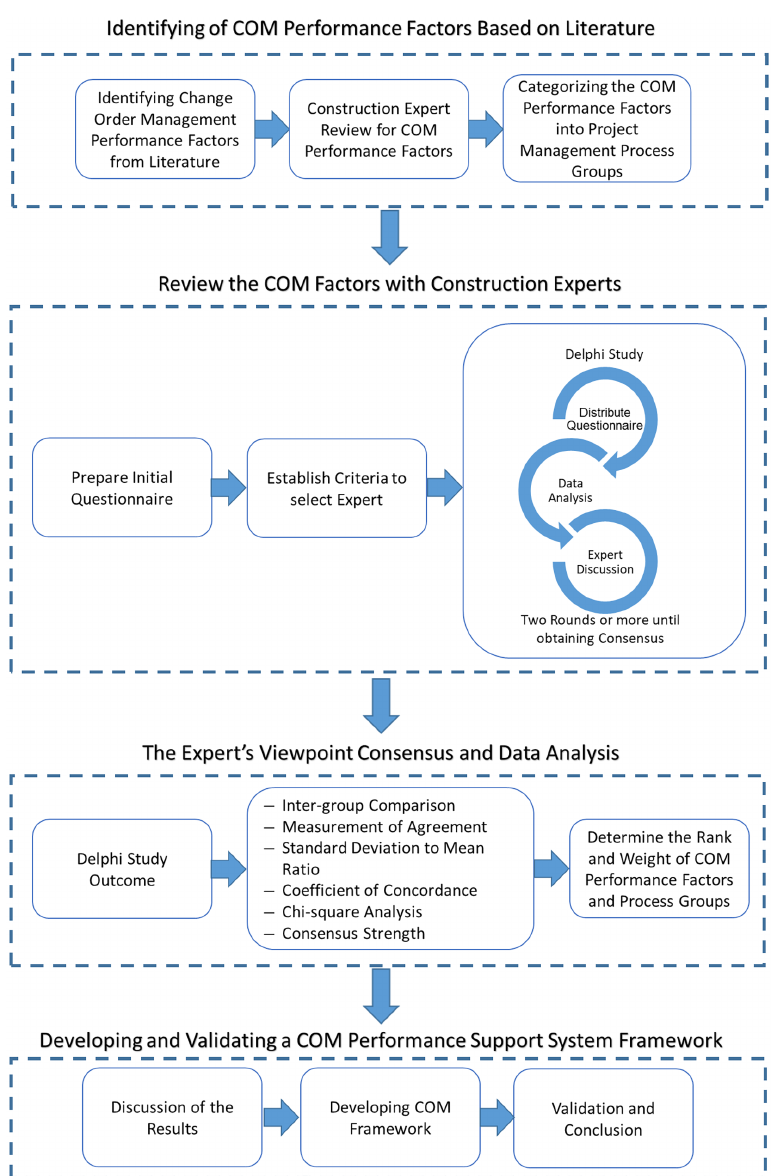
Figure 1. Research methodology for developing a COM support